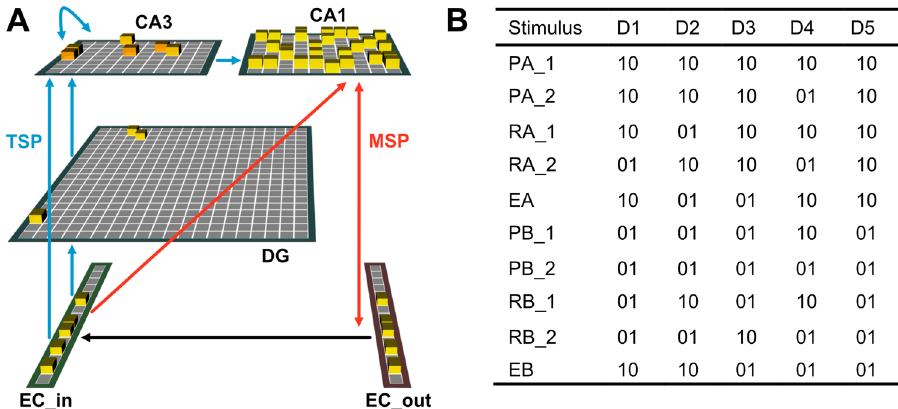
Figure 3. ( A ) A visualization of the hippocampal model used for computational simulations. The input layer, EC_in, represents superficial layers of entorhinal cortex. Information flows along two paths, the monosynaptic and trisynaptic pathways (MSP and TSP). Hidden layers represent hippocampal subfields dentate gyrus (DG), cornu ammonis 1 (CA1) and cornu ammonis 3 (CA3). The model acts as a simple encoder and attempts to replicate its input in EC_out, which represents deep layers of entorhinal cortex. EC_in also receives input from EC_out to simulate big-loop recurrence. ( B ) Vector notation for prototypes, rule-followers, and exceptions (P, R, and E, respectively) in categories A and B. Dimensions 1 through 4 represent the features outer petal colour, outer petal shape, inner petal shape, and central disc colour; dimension 5 indicates category. All features are binary and represented in a padded format in the model (i.e., ‘10’ or